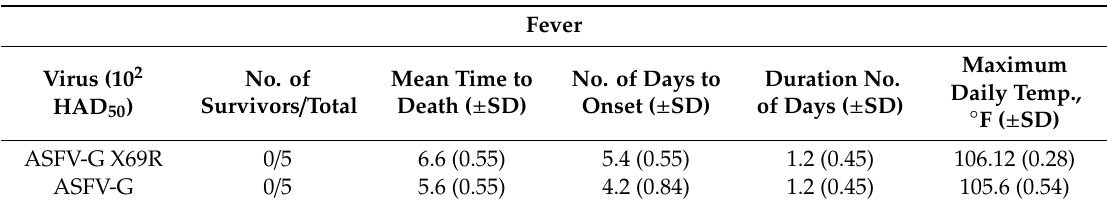
Table 1. Swine survival and fever response following infection with ASFV-G- Δ X69R and parental ASFV-G.